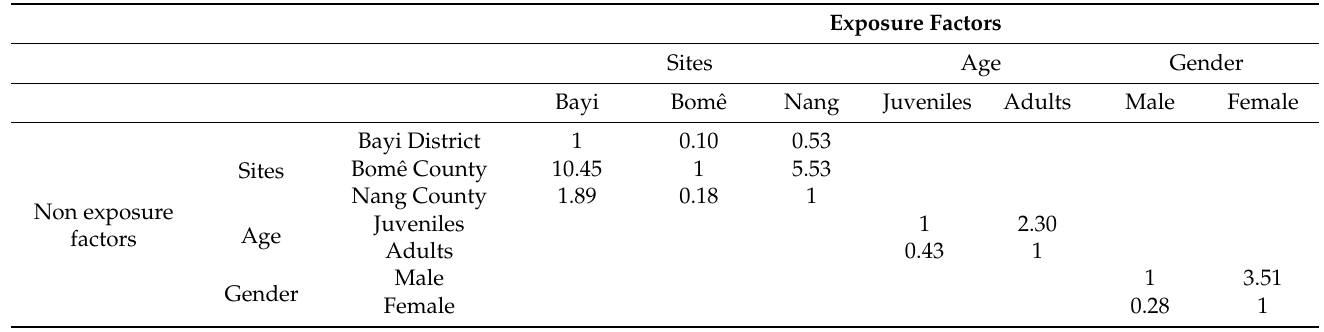
Table 2. Relative risk relationship among different characteristics of Tibetan Pig